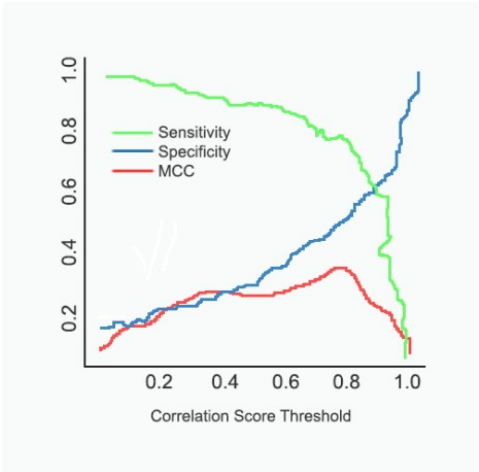
Figure 5. MCC, sensitivity, specificity vs threshold.